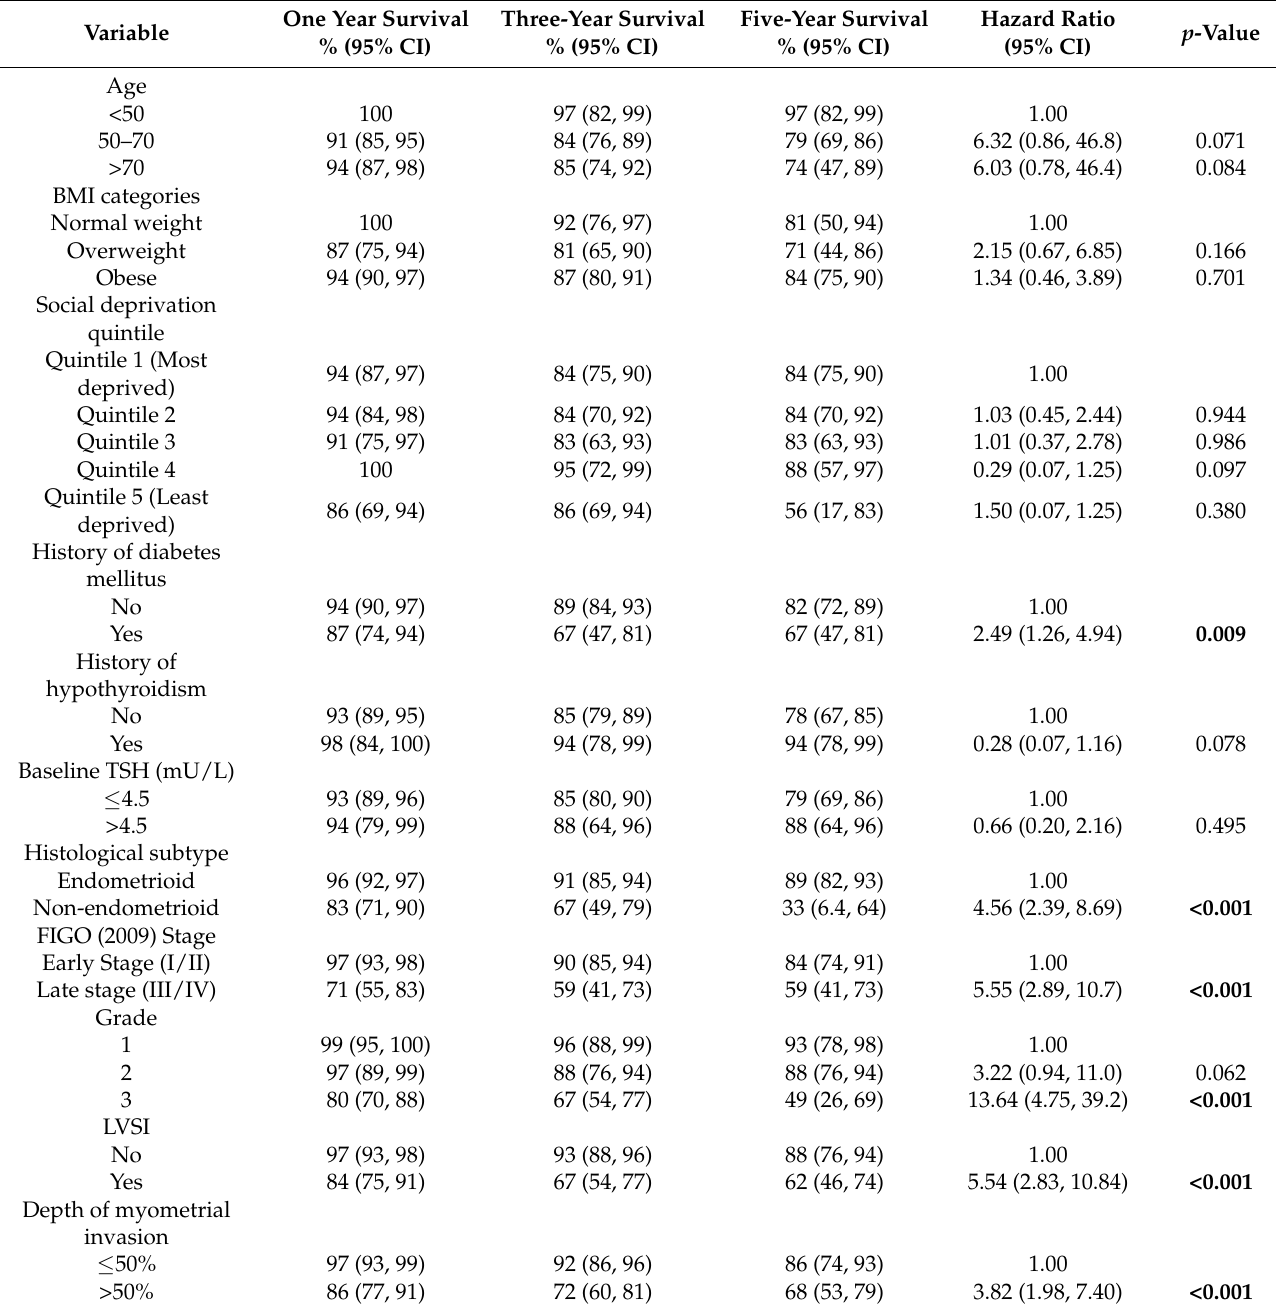
Table 5. One, three and five-year recurrence-free survival rates and unadjusted recurrence hazard ratios and 95% confidence intervals by TSH groupings, demographic and clinical predictor